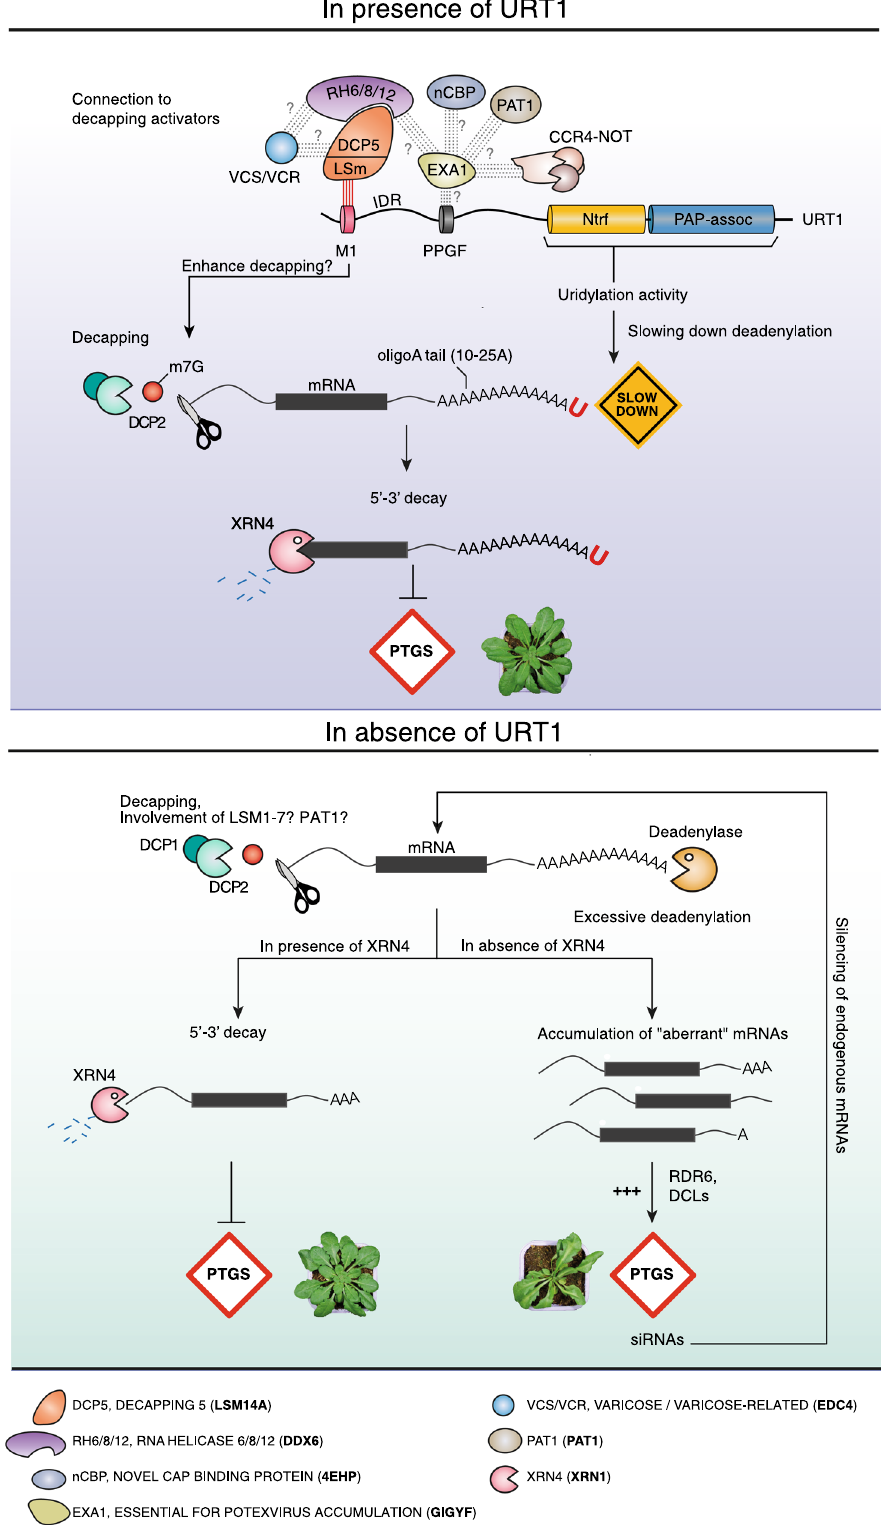
Fig. 7 Model of URT1 mode of action. The name correspondence of RNA decay factors conserved between Arabidopsis and humans is indicated at the other analyses using Arabidopsis, fl owers were harvested from plants grown on soil with 16-h light/8-h darkness cycles (21/18 °C). Agroin fi ltration experiments were performed in leaves of Nicotiana benthamiana plants grown during 4 weeks on soil seq corresponds to Arabidopsis plantlets grown for 24 days in vitro on Murashige with 16-h light/8-h darkness cycles (22/18 °C). & Skoog media with 0.8% agar and 12-h light/12-h darkness cycles (22/18 °C). For